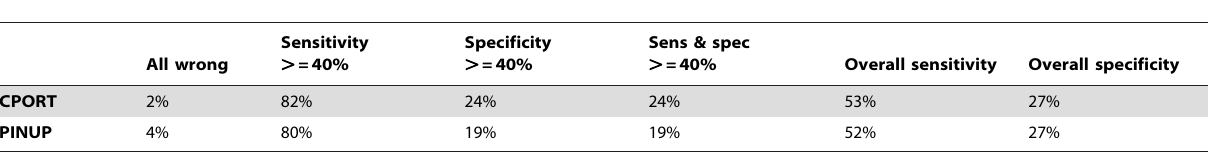
Table 1. Comparison between CPORT and PINUP predictions on the benchmark 2.0.